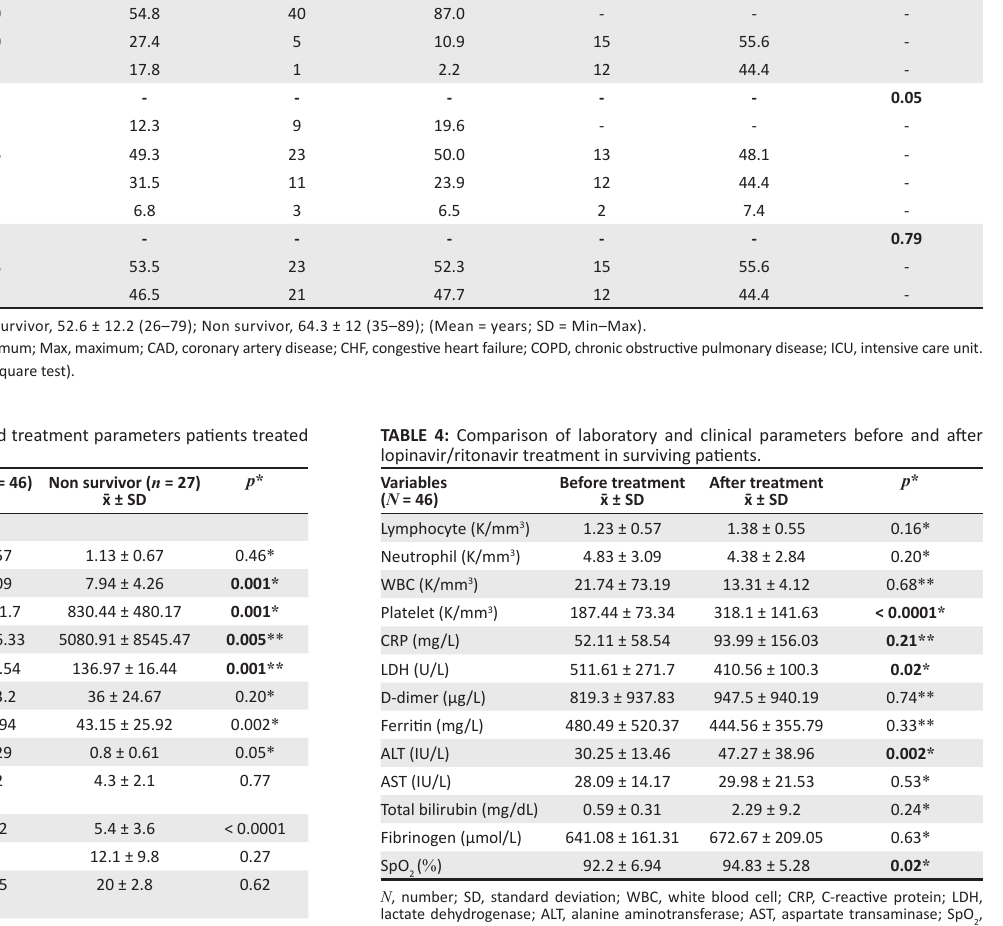
TABLE 1 (Continues...) : Demographics, baseline and clinical characteristics at presentation of patients treated with lopinavir/ritonavir. Variables Treatment location